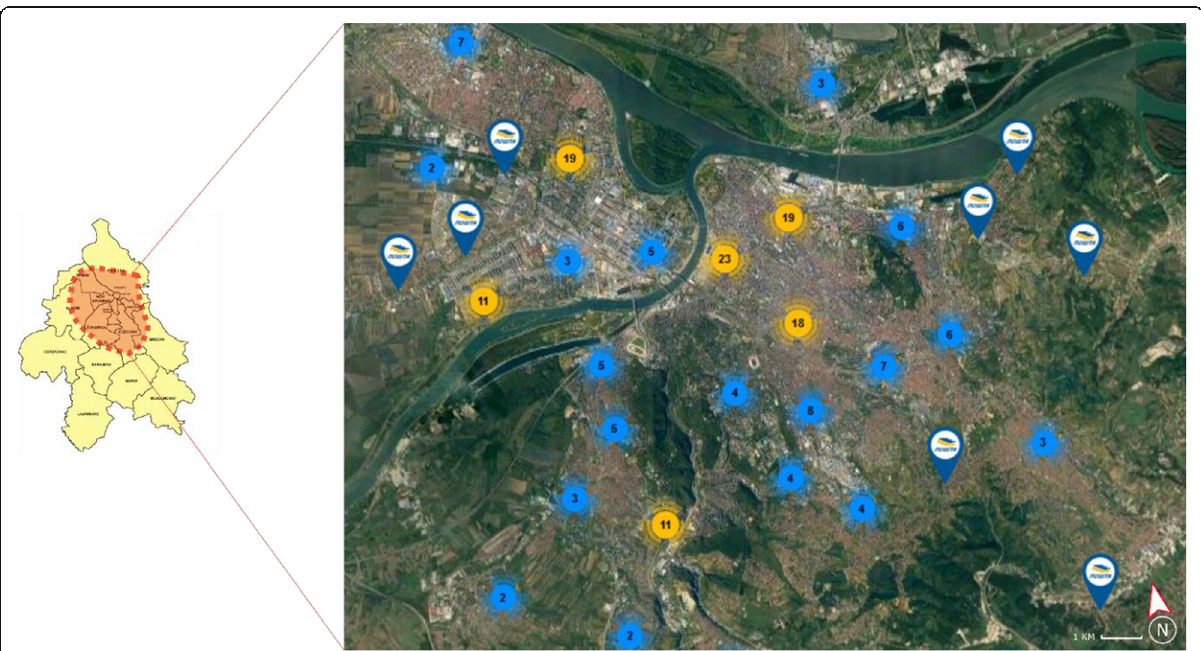
Fig. 7 The network of locations belonging to the public postal operator in